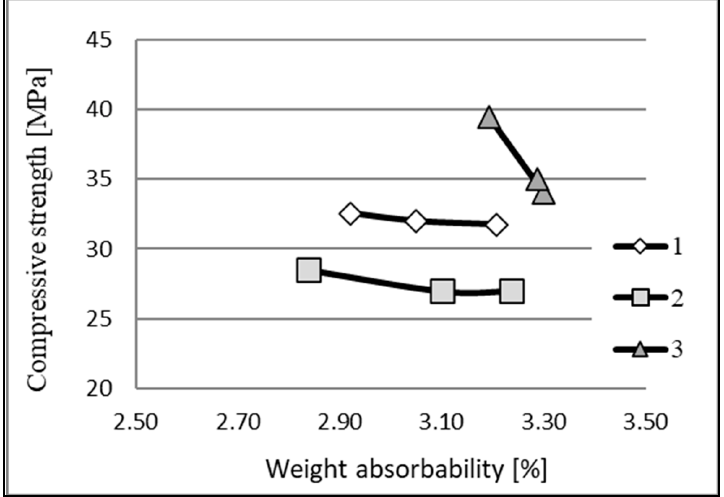
Figure 13. Dependence of the compressive strength on the weight absorption.